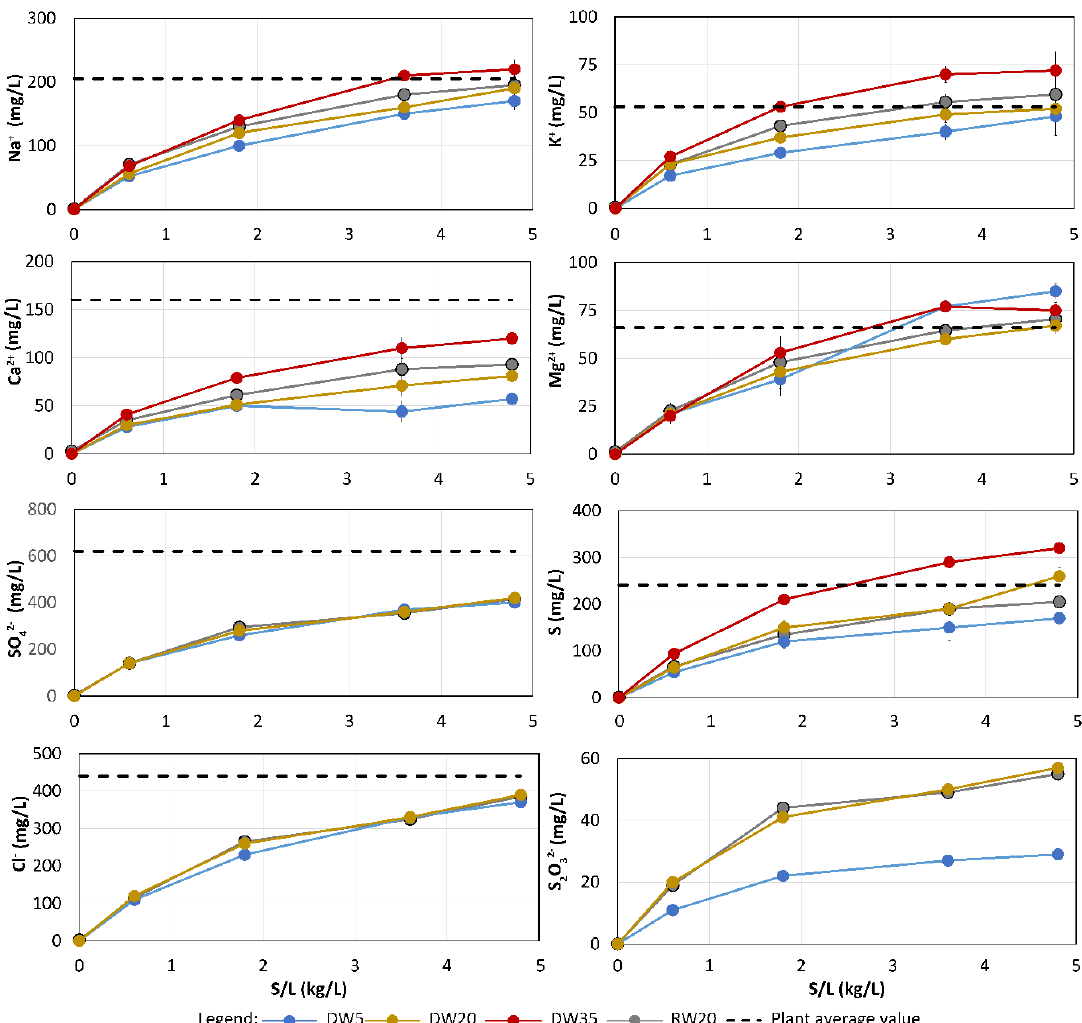
Figure 4. The concentration of major elements in the recycled waters as a function of the solid to liquid (S/L) ratio.